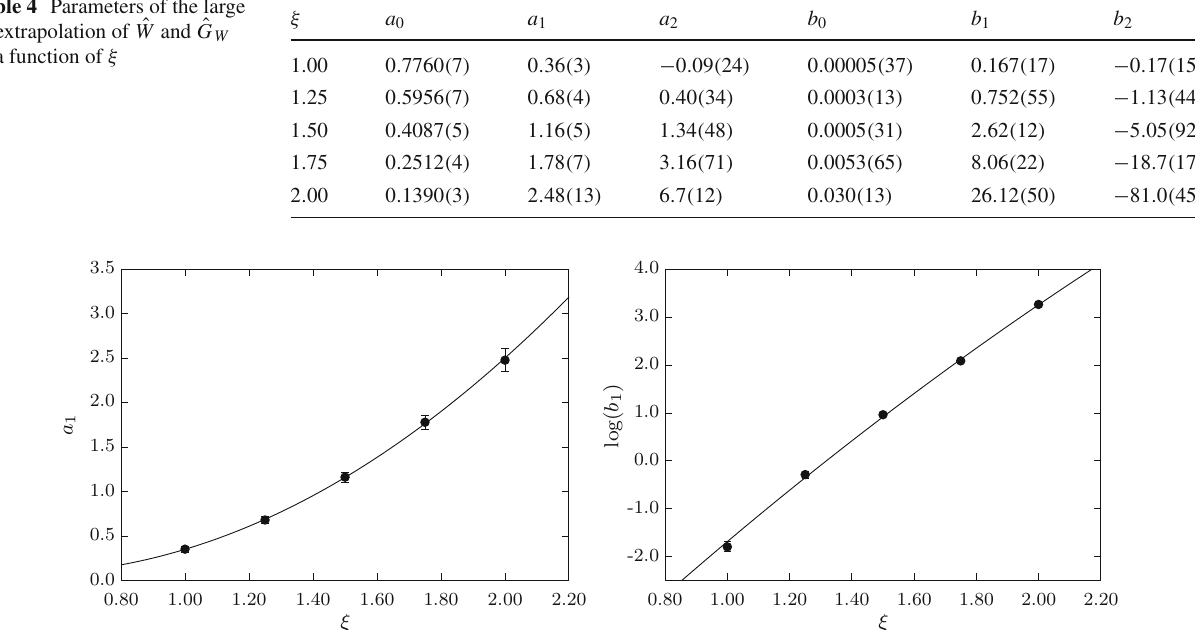
Fig. 9 Plot of the parameters a 1 and log ( b 1 ) as a function of ξ . The interpolating function is a quadratic function in ξ in both